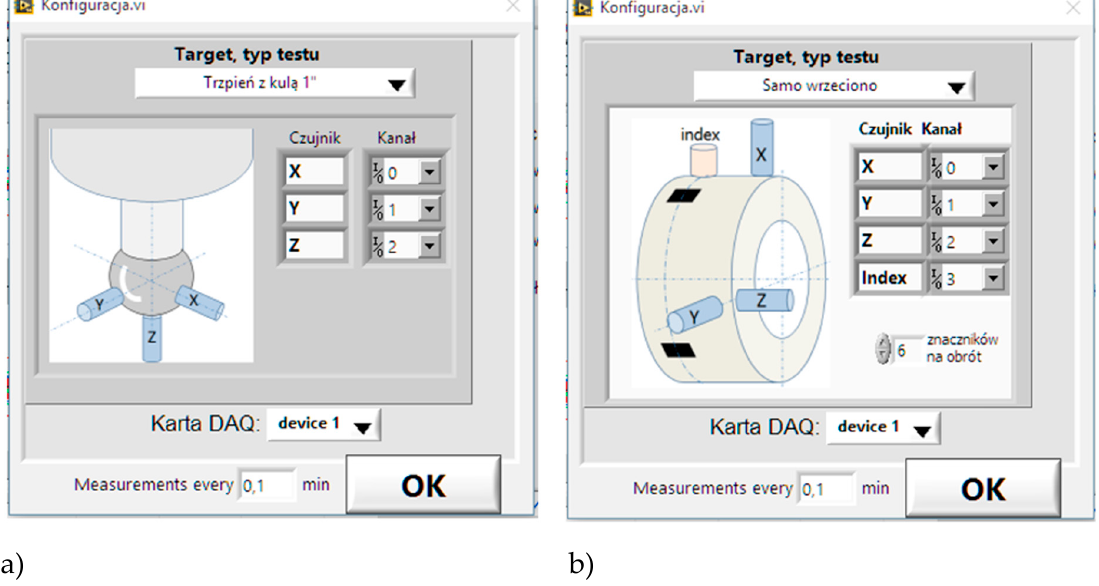
Figure 68. Configuration screens: ( a ) in the basic option and ( b ) with an indexing